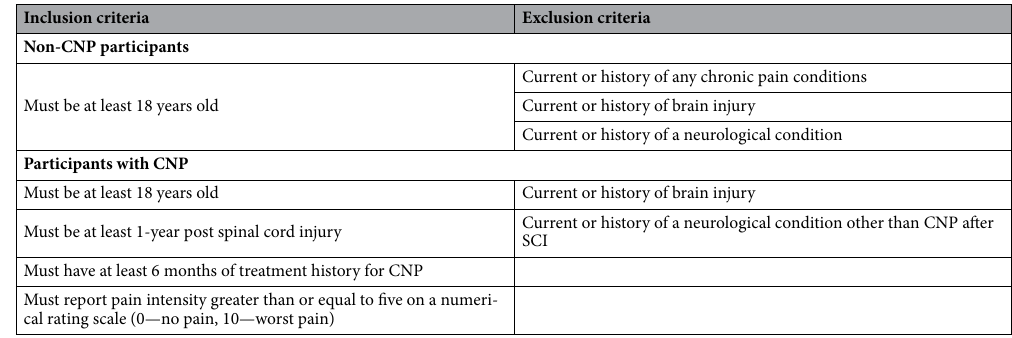
Table 1. Participant inclusion/exclusion criteria. CNP central neuropathic pain, SCI spinal cord injury.